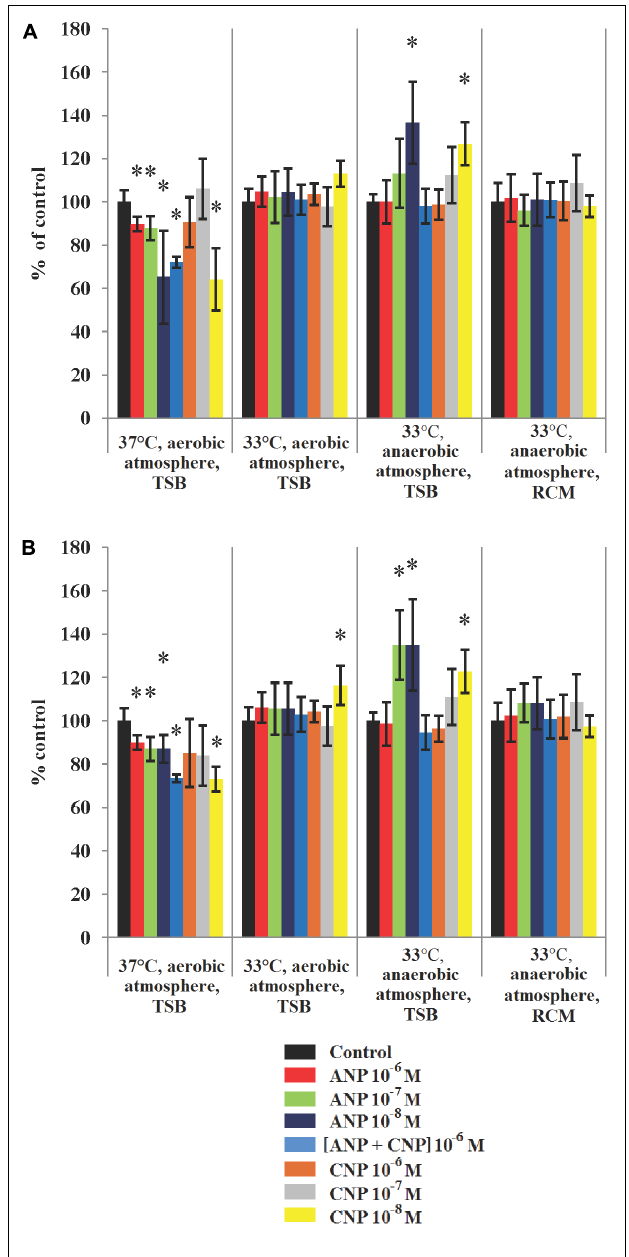
FIGURE 3 | Parameters of monospecies biofilms of S. aureus MFP03 measured by CLSM in different cultivation conditions. (A) Average biofilm biomass density and (B) Average biofilm thickness. ∗ P <